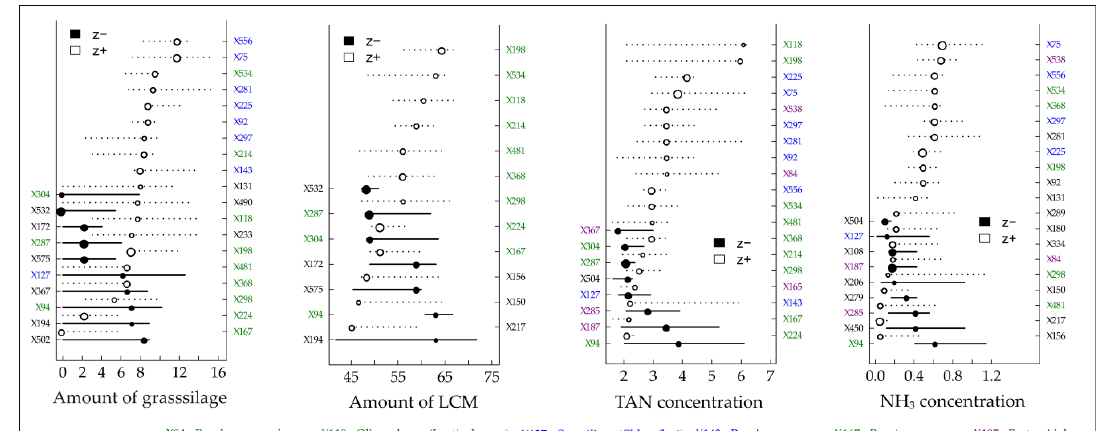
Figure 4. Threshold Indicator Taxa Analysis (TITAN) of the individual density of detected terminal restriction fragments (TRFs) in response to the gradient of the amount of grass silage and liquid cattle manure (LCM) as well as the concentrations of total ammonium nitrogen (TAN) and ammonia nitrogen (NH 3 ). Circles represent the change points of indicative TRFs that decreased (black, negative response, left y-axis) or increased (white, positive response, right y-axis) with increasing gradients and are sized based on the magnitude of the response (z-score; the larger the circle, the stronger the response). Horizontal lines represent 5th and 95th quantiles of 500 bootstrap replicates. Color code: green = TRFs recorded in all four gradients, blue = TRFs recorded in the gradients for the amount of grass silages as well as the concentration of TAN and NH 3 , violet = TRFs recorded for the gradients of the TAN and NH 3 concentrations.